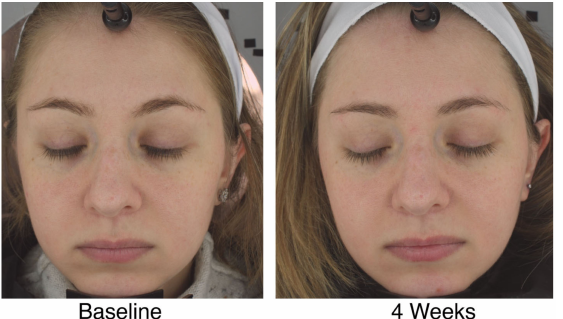
Figure 5. Facial images of a study participant at baseline and week 4 from the PE group.